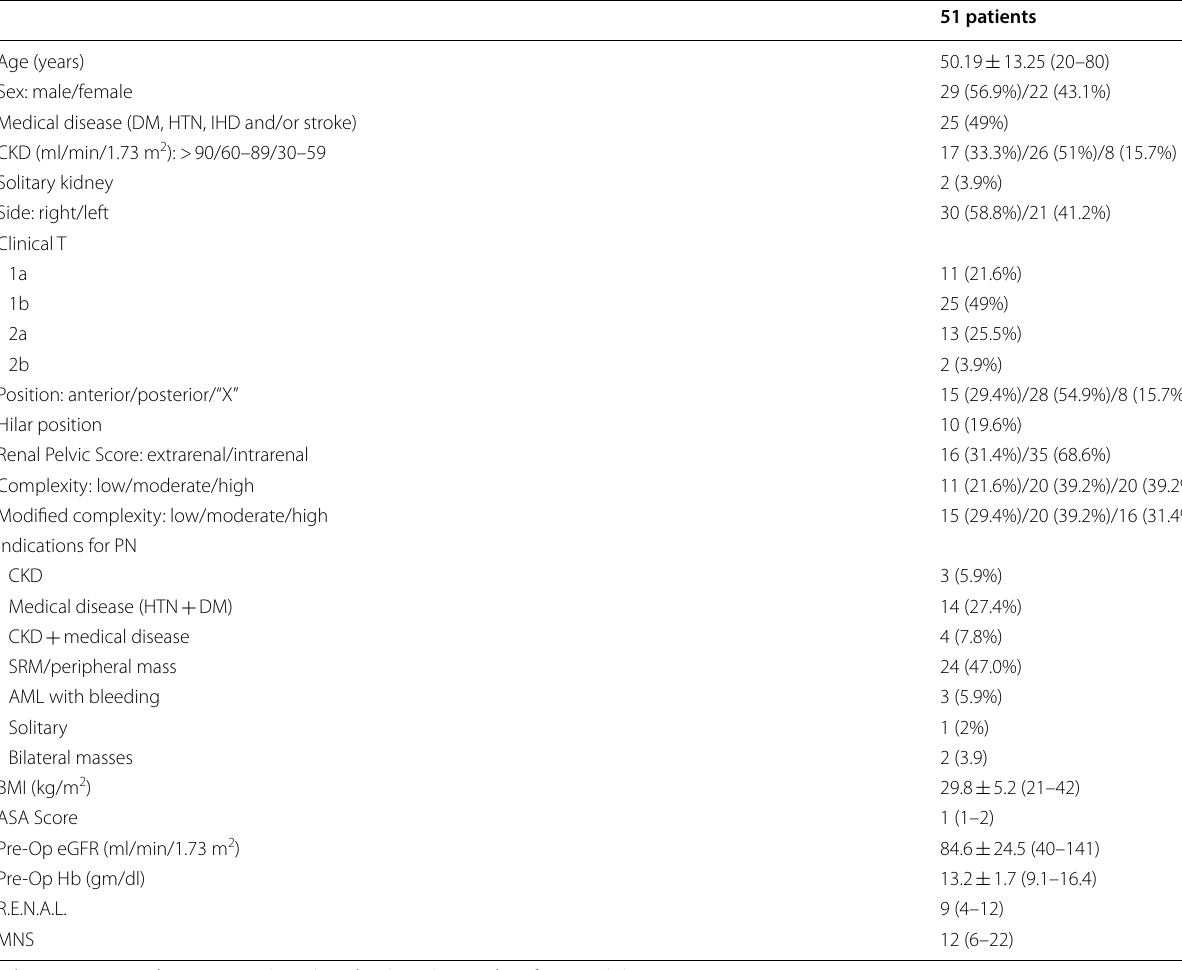
Values were presented as mean SD (range), median (range) or number of patients (%) as appropriate ± ASA American society of anesthesiology, BMI body mass index, CKD chronic kidney disease, DM diabetes mellitus, eGFR estimated glomerular filtration rate, Hb hemoglobin, HTN hypertension, IHD ischemic heart disease , MNS newly modified nephrometry score, Pre - Op preoperative, SRM small renal